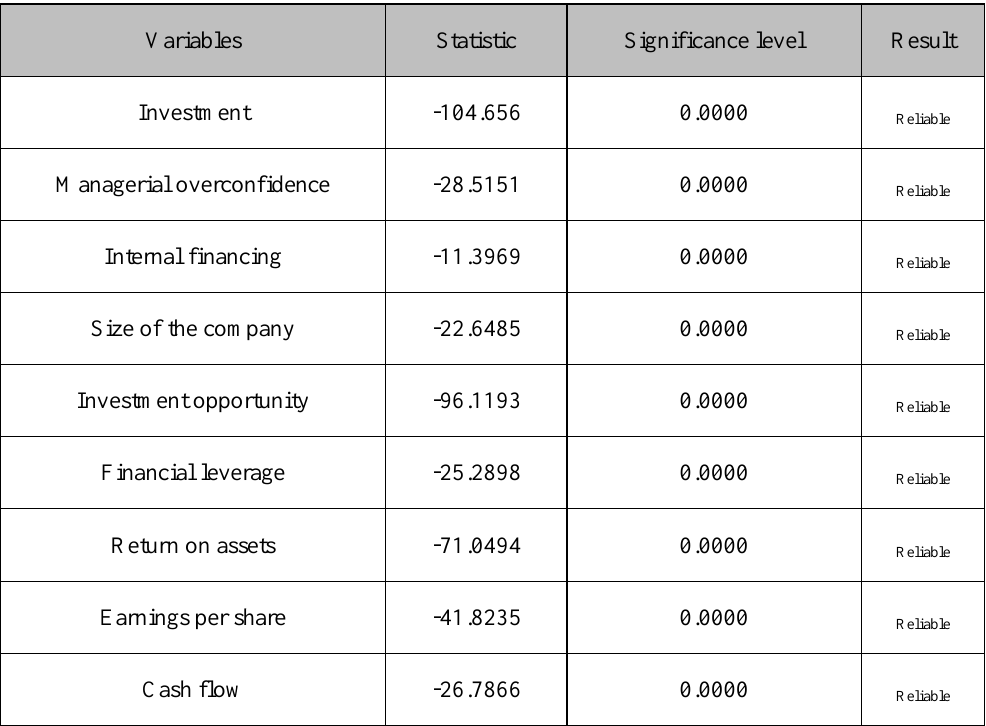
Table 5. Variables reliability test -